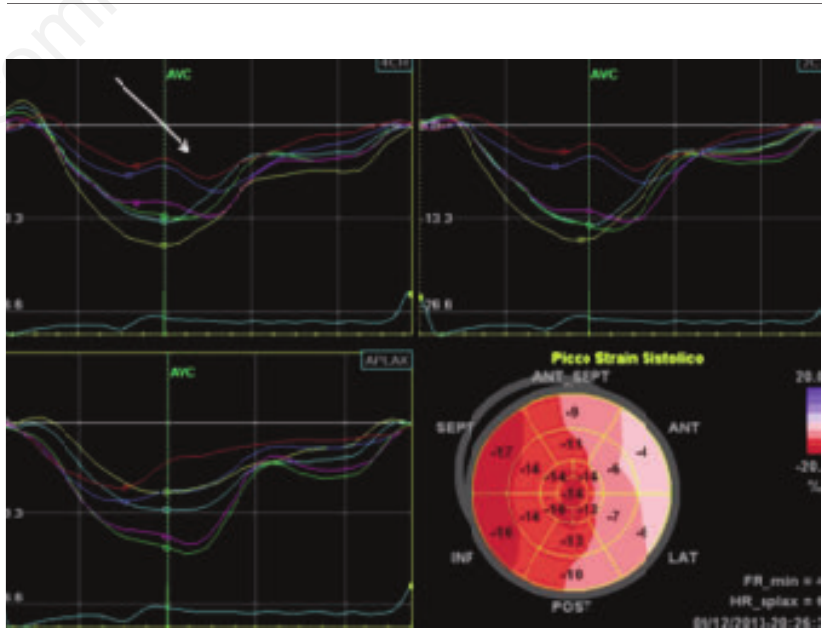
Figure 4. Two-dimensional strain study in a patient with hypertrophic cardiomyopathy: re-duced peak of strain of the hypertrophic segments evidenced in the corresponding curve (arrow) and reduced segmental myocardial deformation evidenced in the schemat- ic bull